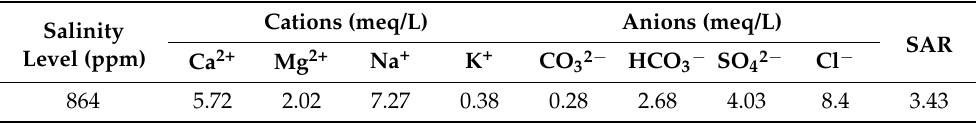
Table 2. Chemical properties and compositions of the irrigation water. Salinity Level